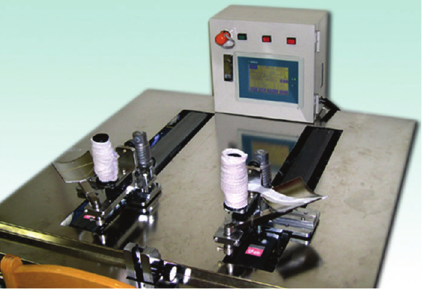
Figure 15: BFIAMT. Reprinted with permission (http://www.bmes